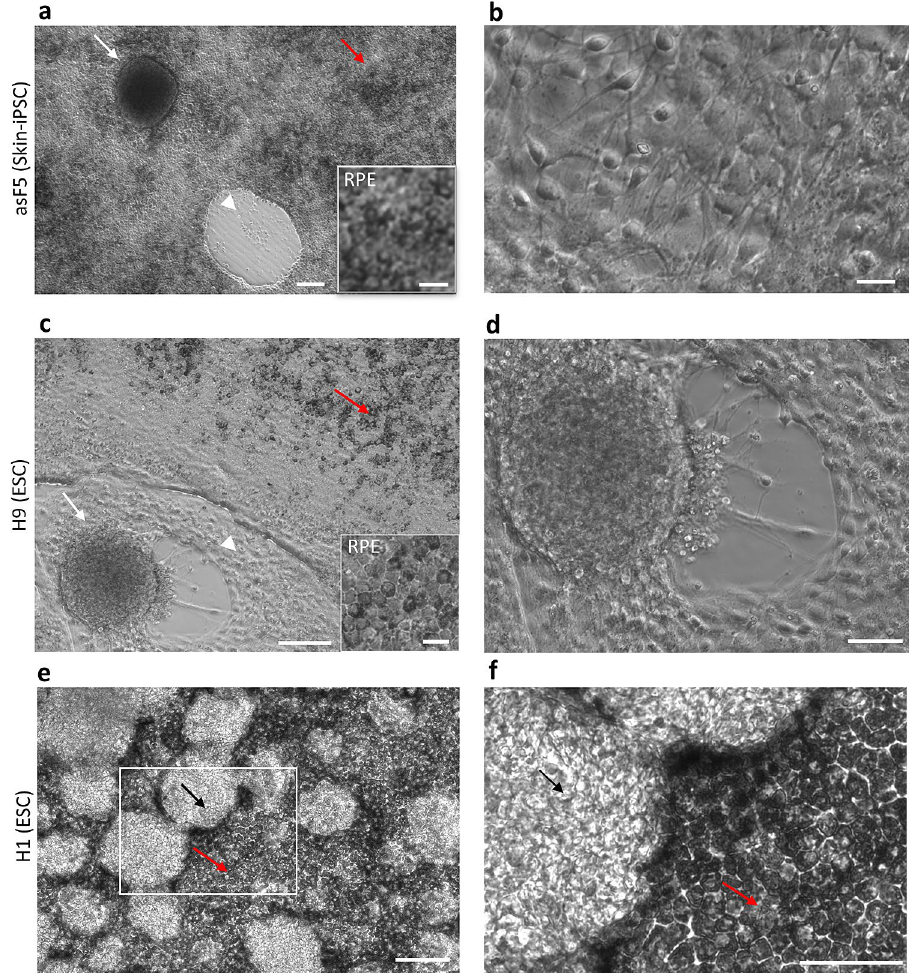
Figure 1. Morphological differences in non-RPE cells from skin-iPSC and ESC sources. ( a ) Dome-shaped clusters (white arrow) of non-RPE cells and empty area formed by detachment of a cluster (white arrowhead) in asF5 (skin-iPSC) differentiation cultures close to a polygonal RPE cell sheet (red arrow, inset). Scale bar, 100 μm. Inset scale bar, 20 μm. ( b ) Magnified view of the non-polygonal non-RPE cells with protrusions. Scale bar, 20 μm. ( c ) Cluster of non-RPE cells (white arrow) surrounded by non-polygonal non-RPE cells (white arrowhead) and RPE cells (red arrow, inset) in H9 (ESC) differentiation cultures. Scale bar, 100 μm. Inset scale bar, 20 μm. ( d ) Magnified view of the non-RPE cells with protrusions. Scale bar, 50 μm. Non-RPE cells (black arrow) in H1 (ESC) differentiation cultures intermingled with pigmented RPE cells (red arrow). Scale bar, 100 μm. Non-RPE clusters (black arrow) in H1 (ESC) differentiation cultures intermingled with RPE cells (red arrow) and non-RPE cells, scalebar 100 μm. ( f ) Magnified view of the area shown inside the white box in ( e ). Scale bar, 50